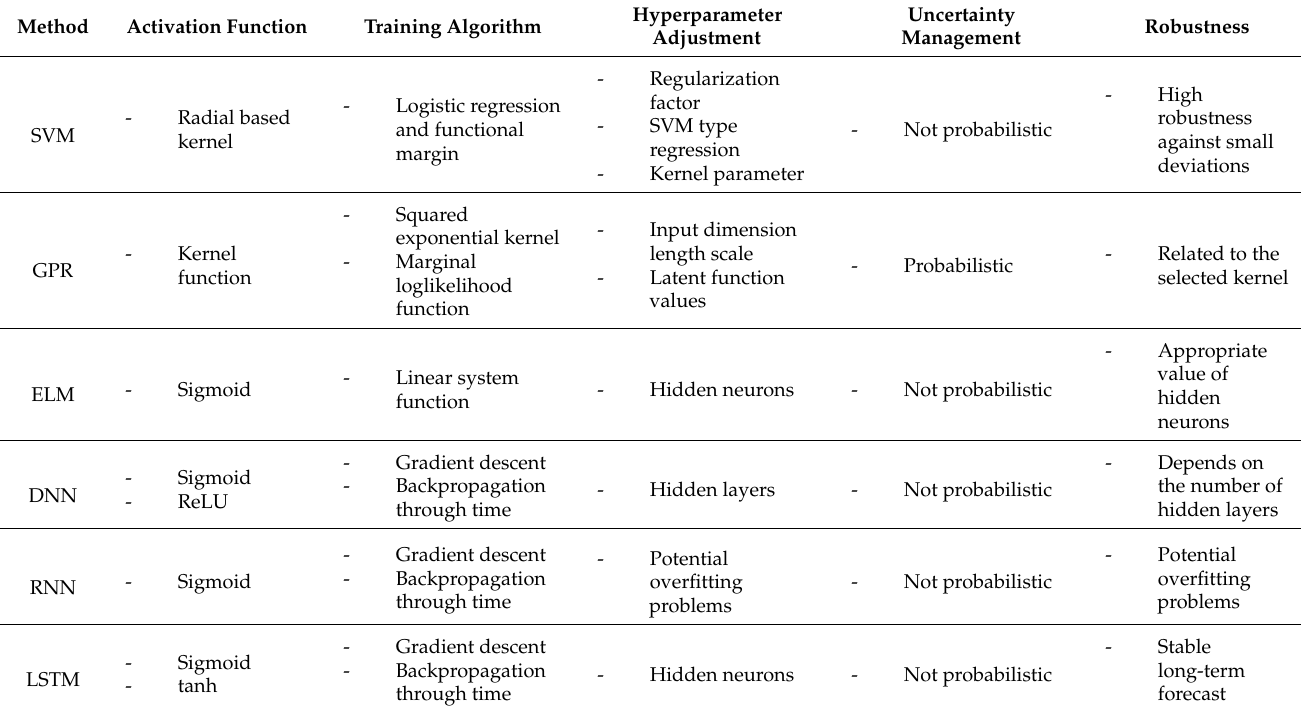
Table 2. Summaries of the different criteria used for accuracy assessment defined in this section.